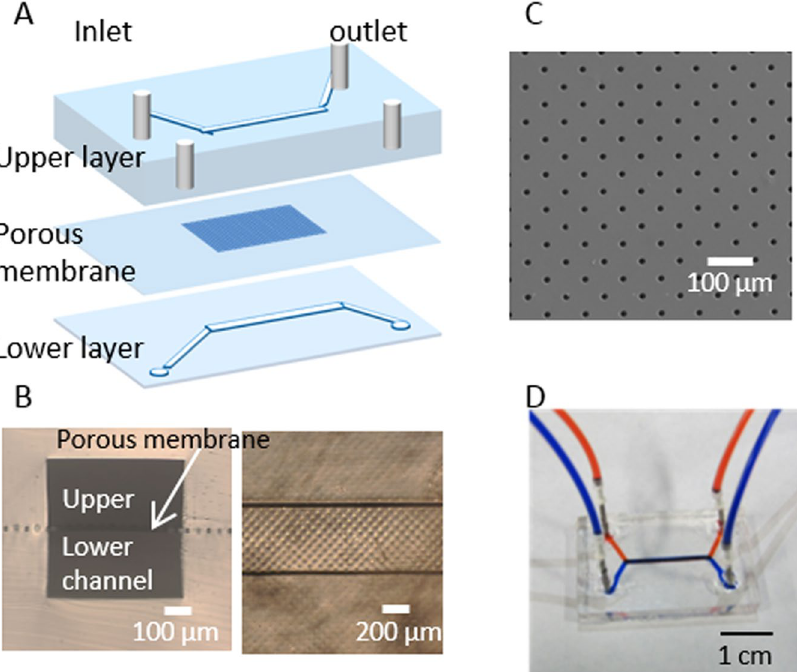
Figure 1. Microfluidic device configuration. ( A ) Exploded view and schematic. ( B ) Cross-section (left) and top (right) view of the device. ( C ) SEM image of the porous membrane. ( D ) Photograph of a device with dyes in fluidic